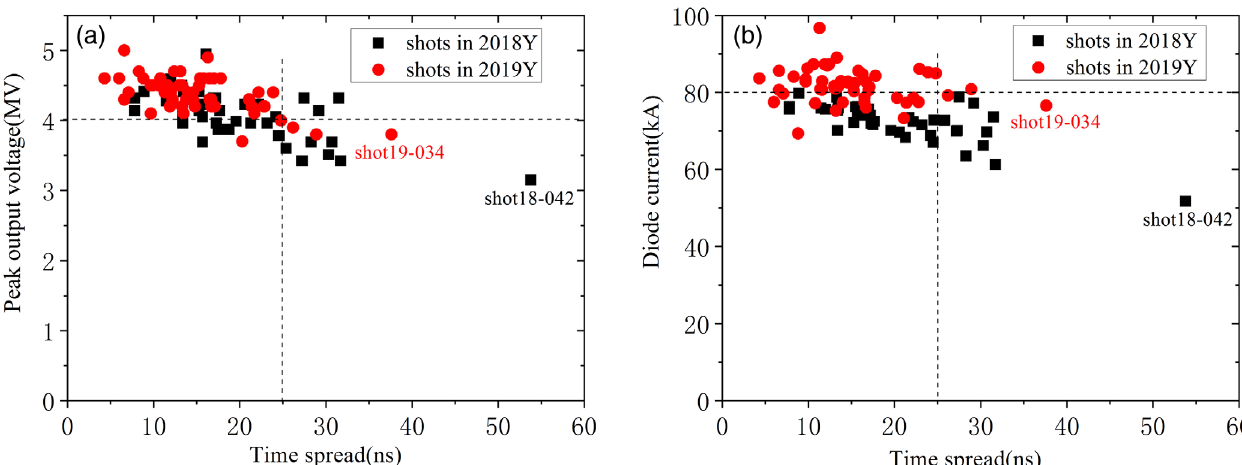
FIG. 15. Effects of the first-to-last time spread ( t ) on the peak output voltages and diode currents in a statistics of almost 100 shots. spread (a) Peak output voltage, and (b) peak diode current. The black dots represent the shots conducted in 2018, while the red dot represent the shots in 2019 after a maintenance on the four electrically-triggered gas switches to improve the drive synchronous.